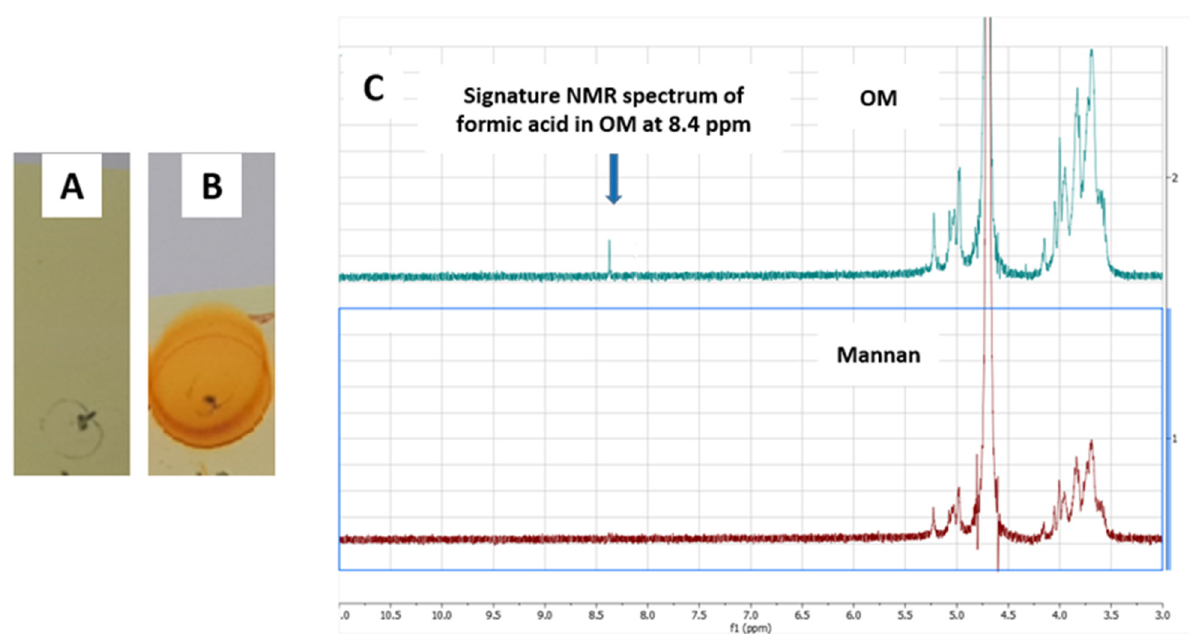
Figure 6. Confirmation of OM by 2,4-DNPH test and NMR study. ( A ) Mannan with 2,4-DNPH solution, ( B ) OM with 2,4-DNPH solution and ( C ) NMR spectrum of mannan and OM.